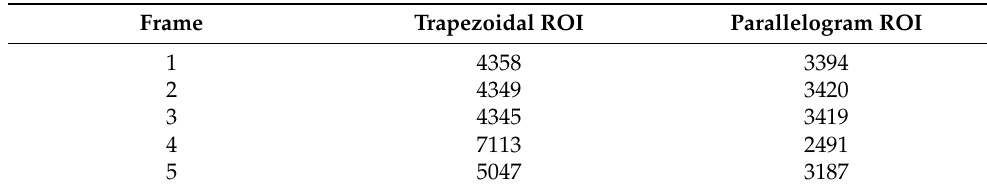
Table 1. Comparison between the number of edge pixels using a trapezoidal ROI and the number of edge pixels using a parallelogram ROI. ( n = 40).